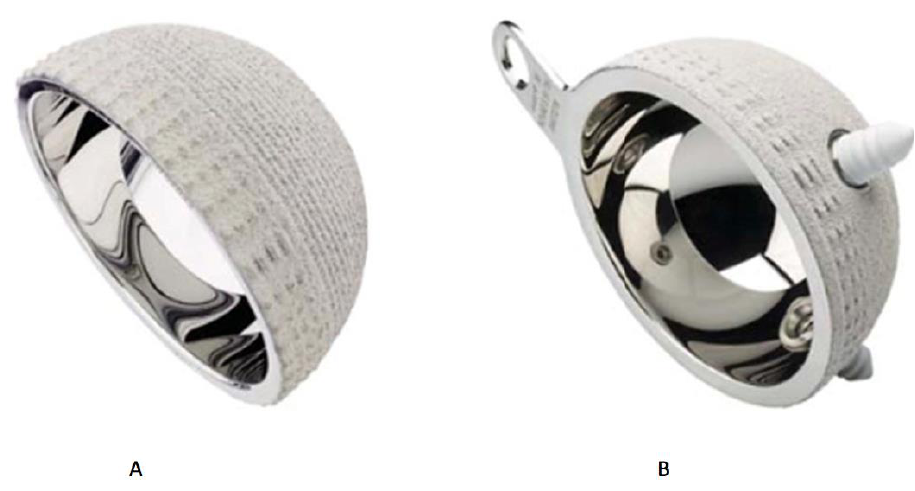
Figure 3. Part ( A ) shows the Sunfit SERF (cylindrospheric design) while part ( B ) shows the Novae E (Tripode configuration). Courtesy of SERF, Décines, France.